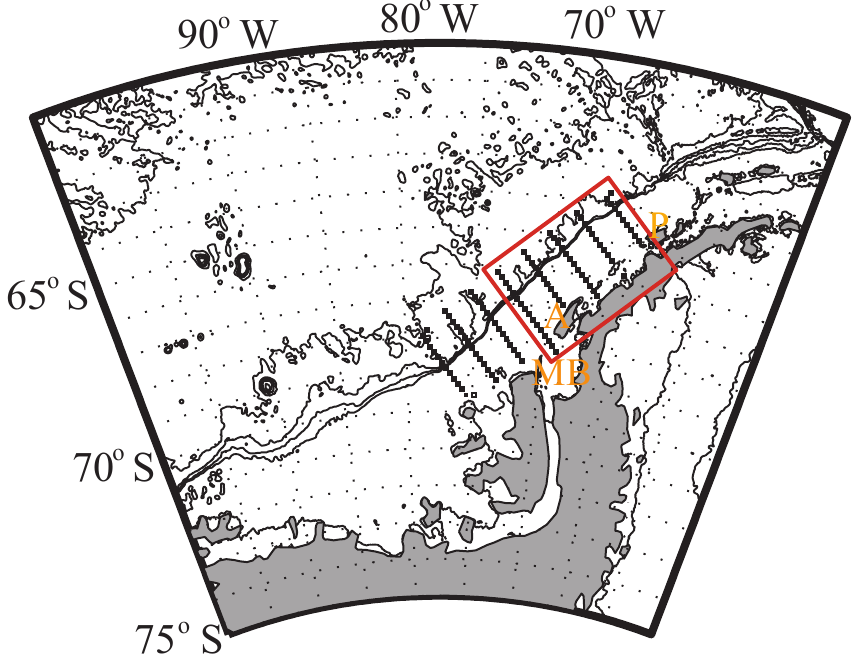
Figure 1. Map of the West Antarctic Peninsula (WAP) and study area of the Palmer Antarctica Long Term Ecological Research (PAL-LTER) project. The red box shows the main study grid that has been sampled for inorganic carbon chemistry since 1993, and is defined in this study as the central subregion. The black squares indicate the stations (20km apart) arranged in onshore to offshore lines spaced 100km apart along the peninsula. The inorganic carbon measurements from stations south of the central subregion were only added in 2009. The central subregion also contains surface underway p CO 2 observations that were used in the trend analysis (Sect. 3.5). P: Palmer Station on Anvers Island; A: Adelaide Island; and MB: Marguerite